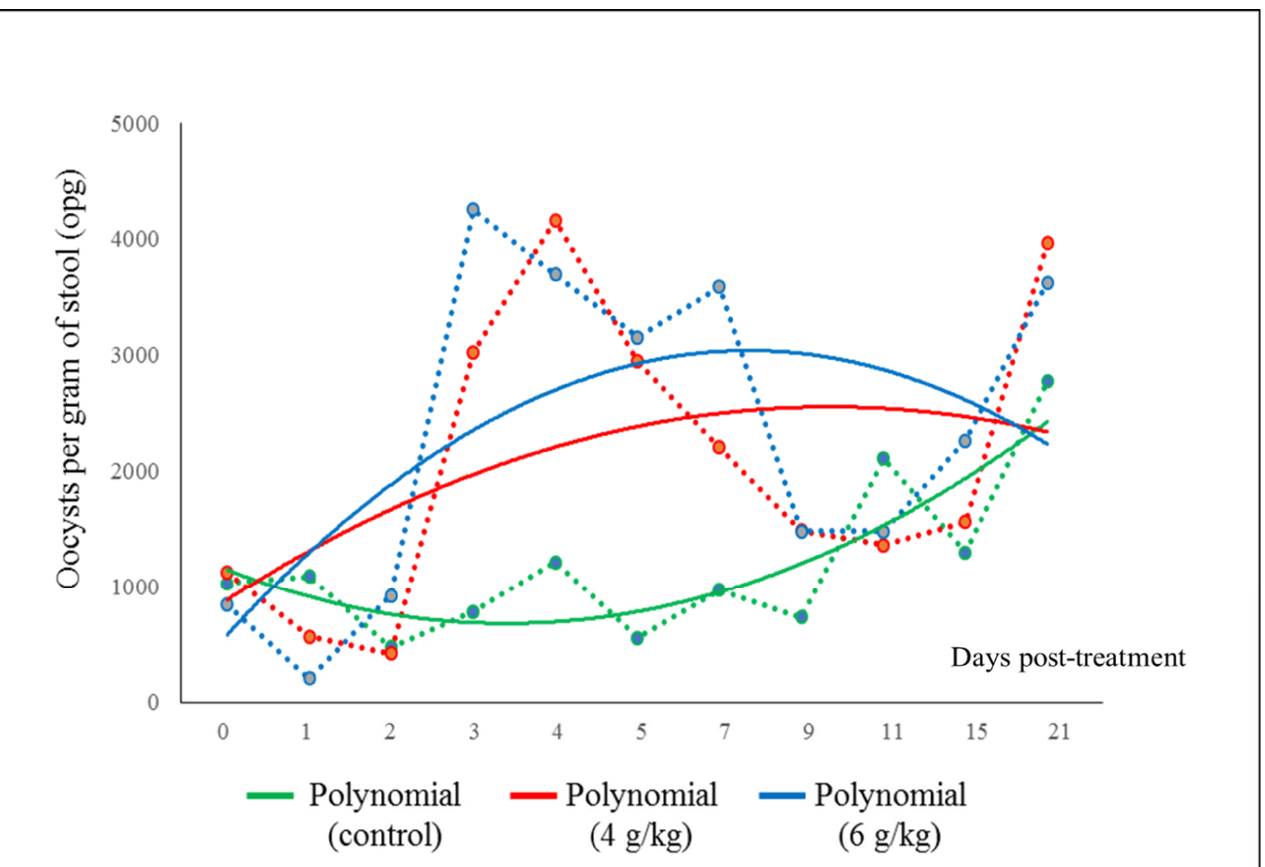
Figure 2. Eimeria oocyst excretion reduction trends for the treatments administered. The dashed line indicates the oocysts eliminated each day (opg) in accordance with the seed dose.